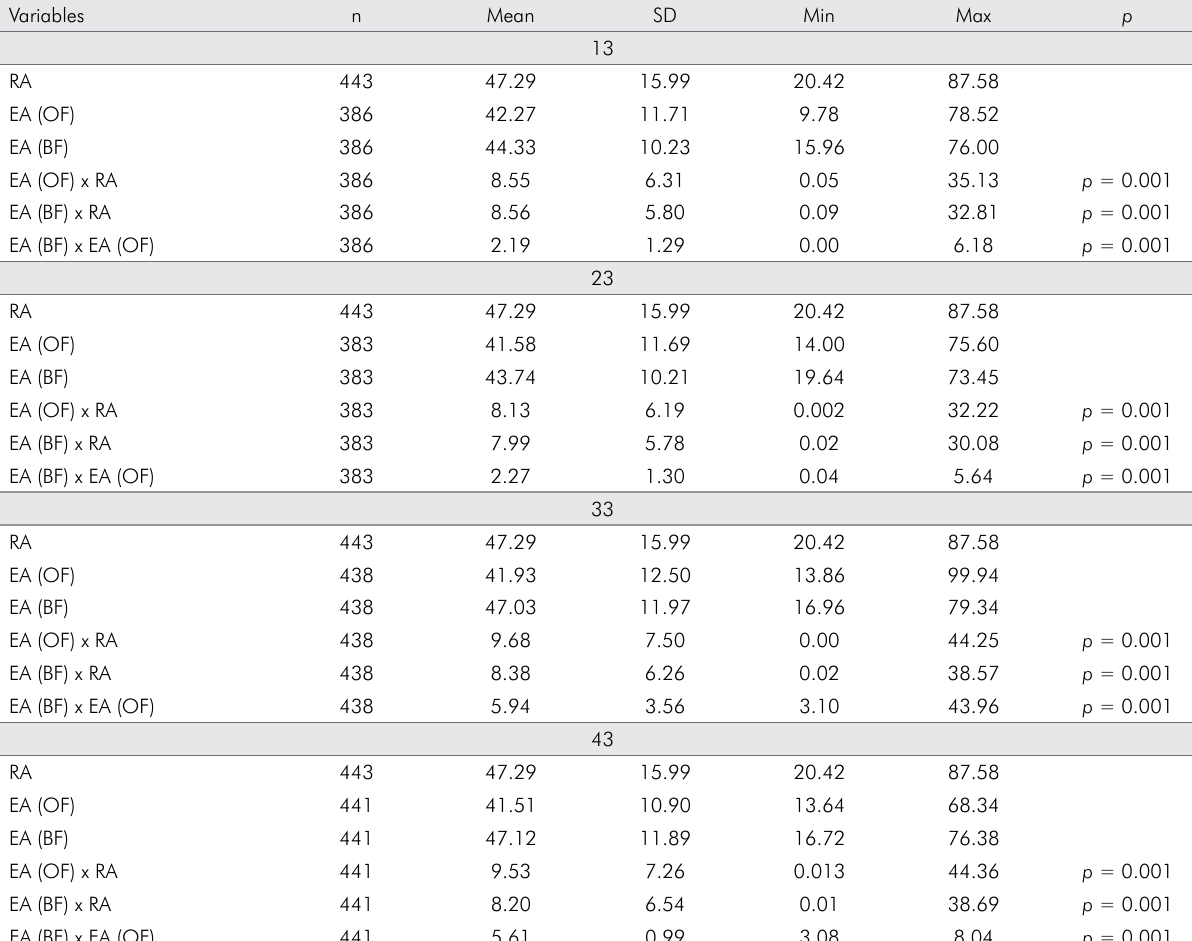
Table 1. A descriptive analysis and comparisons among real ages (RA) and estimated ages (EA) by performing evaluations of the canines.